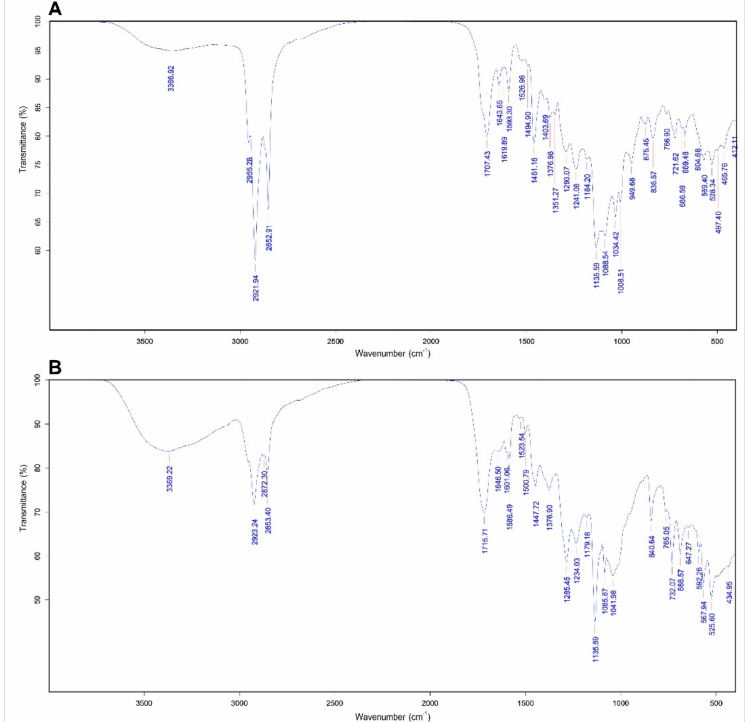
Figure 9. FTIR spectra of original textile dyes ( A ) and decolourised dyes after 12 days. ( B ) Treatment with immobilised T. hirsuta